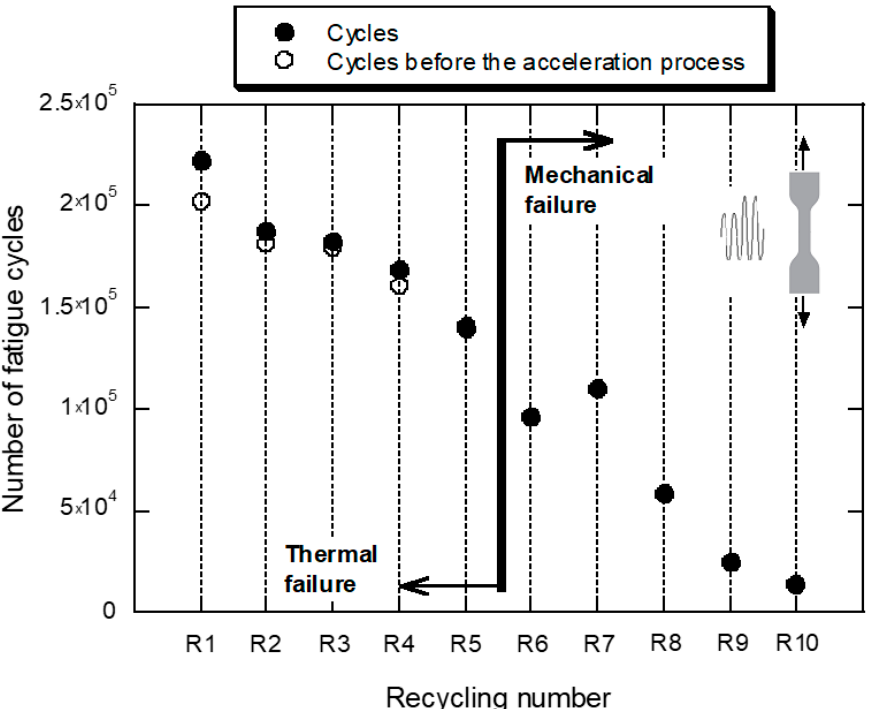
Figure 8. Evolution of the number of fatigue cycles as a function of the recycling number.